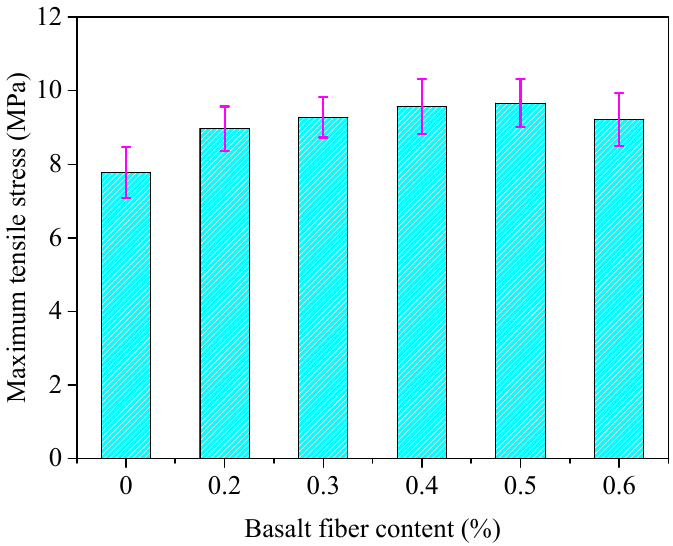
Figure 16. Maximum tensile stress of basalt reinforced asphalt mixture with different fiber contents, where the testing temperature was set to − 10 °C.